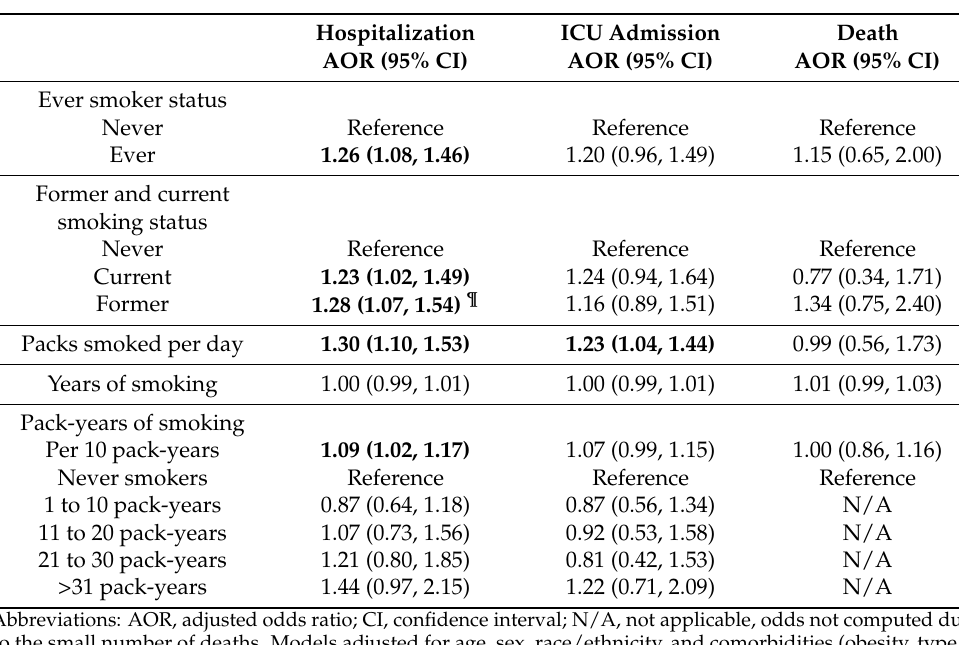
Table 4. Adjusted odds ratios for the associations of smoking with severe COVID-19 outcomes.